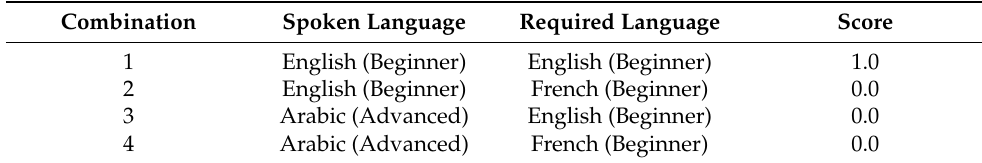
Figure 8. CQ_01: Which job posts could be recommended to a migrant? Table 4. Language